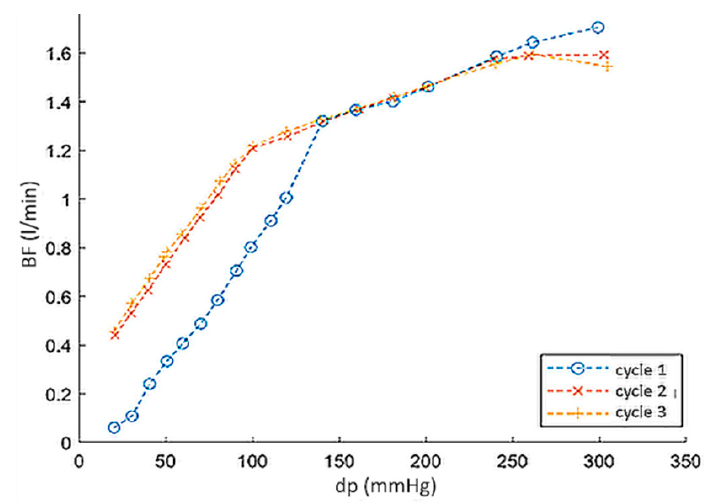
Figure 13. Outflow valve ring with channels improving the leaflets washing.